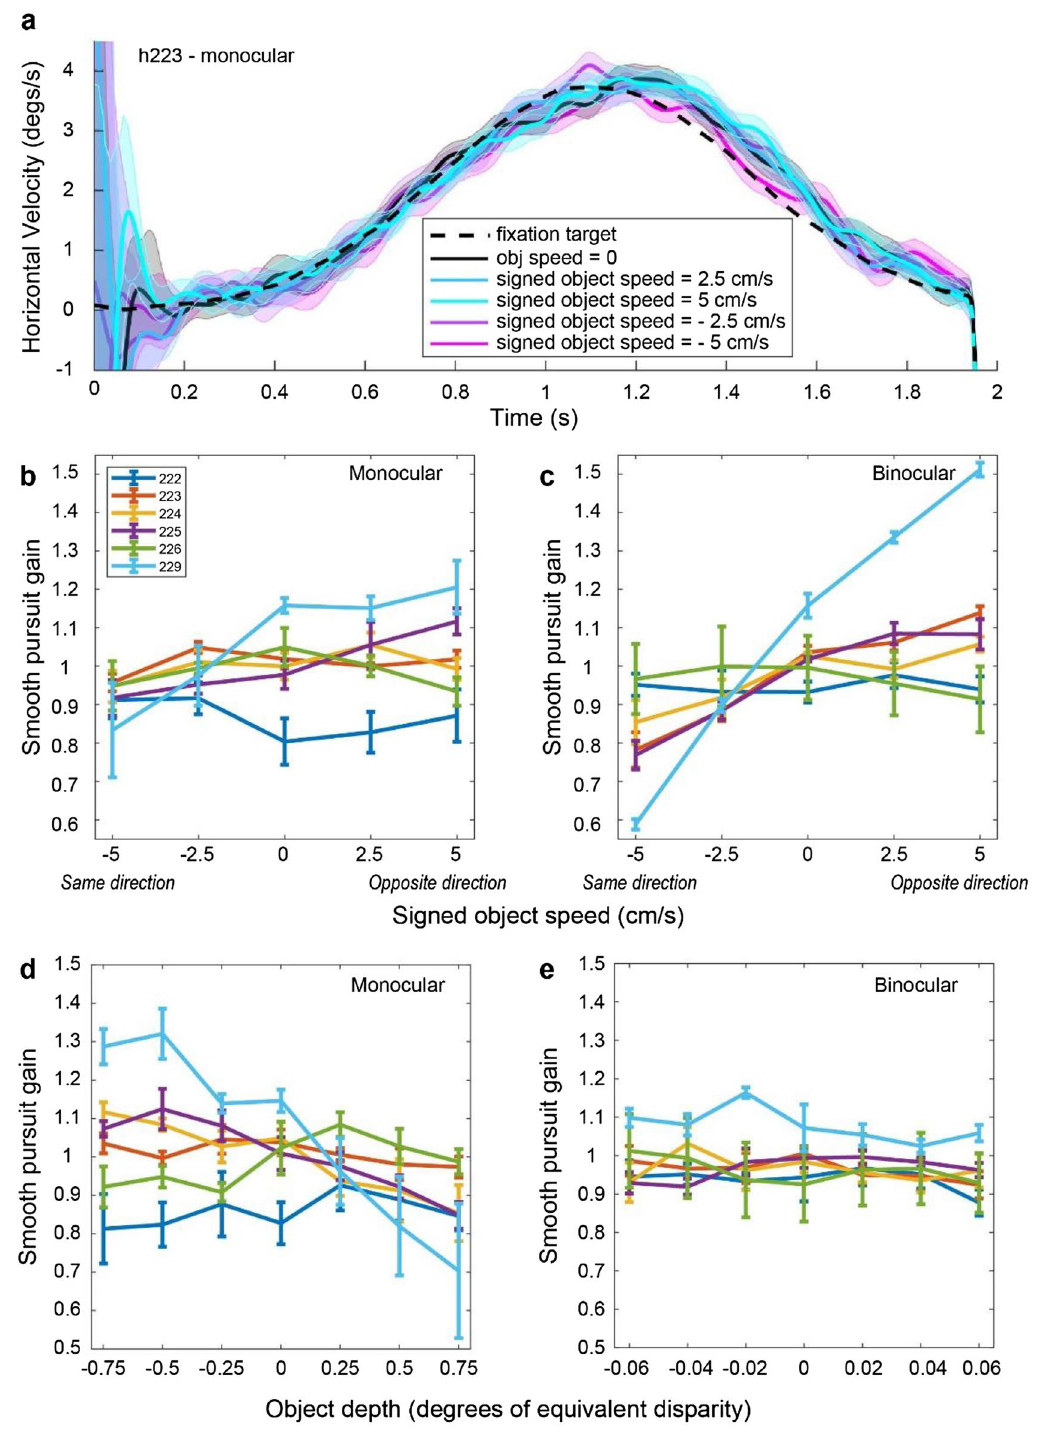
Figure 7. Example eye traces and pursuit gain analyses. ( a ) Averaged eye velocity traces for different SOS conditions from subject 223 in the monocular condition. Shaded error bands represent 95% confidence intervals. ( b ) Pursuit gain is plotted as a function of SOS for each subject (colored lines) in the monocular condition. Error bars represent SEM. ( c ) Pursuit gain as a function of SOS for the binocular condition; format as in panel ( b ). ( d ) Pursuit gain plotted as a function of object depth for each subject in the monocular condition. Error bars represent SEM. ( e ) Pursuit gain as a function of depth for the binocular condition; format as in panel ( d